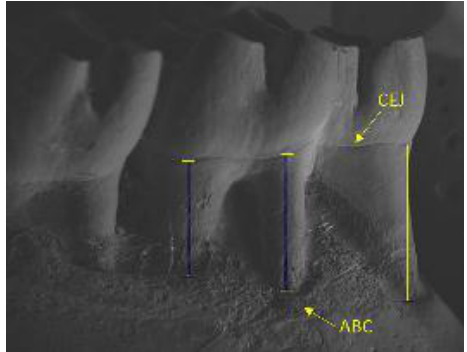
Figure 2. Representation of alveolar bone loss measure from the cementoenamel (CEJ) junction until the alveolar bone crest (ABC) by scanning electron microscopy.